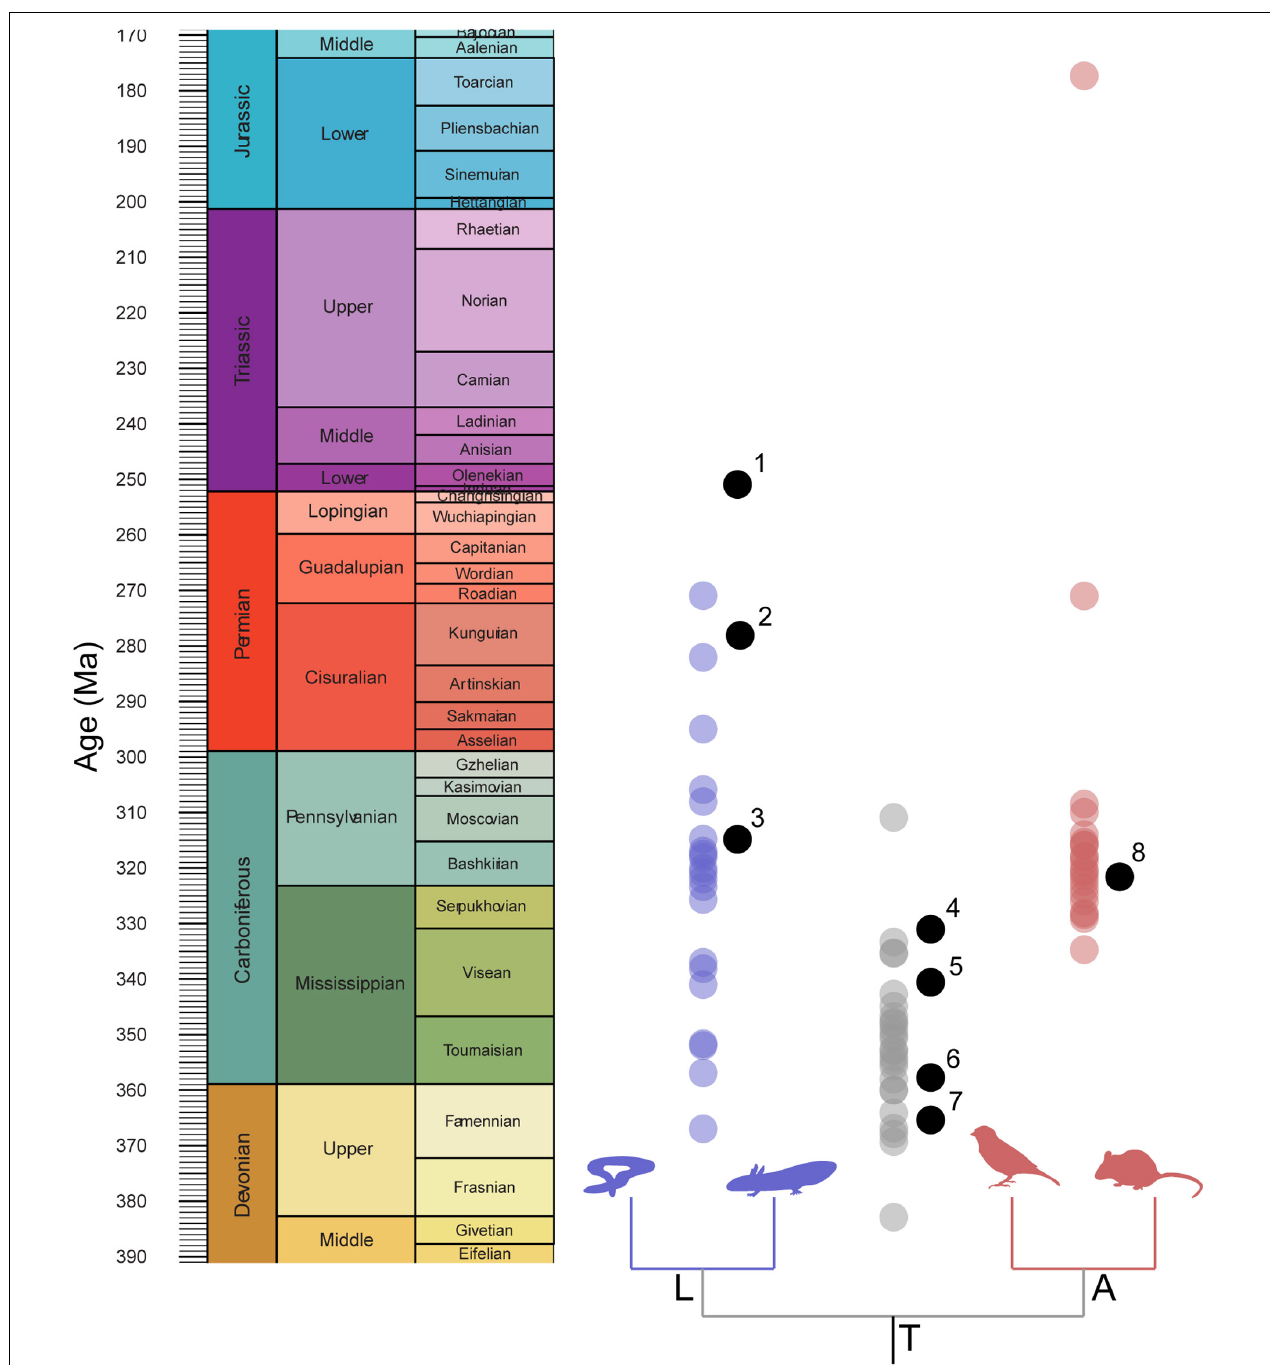
FIGURE 2 | Distribution of implied node calibration ages compared with distribution of mean node-age estimates. Node estimates drawn from timetree.org. 1, Triadobatrachus massinoti ; 2, Gerobatrachus hottoni ; 3, Amphibamus grandiceps ; 4, Balanerpeton woodi ; 5, Lethiscus stocki ; 6, Horton Bluff tetrapod fauna; 7, Tulerpeton curtum ; 8, Hylonomus lyelli